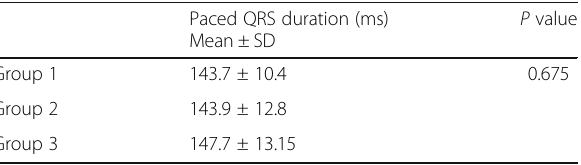
Table 4 Comparison of paced QRS duration difference as regards the paced QRS vector groups in leads I and III